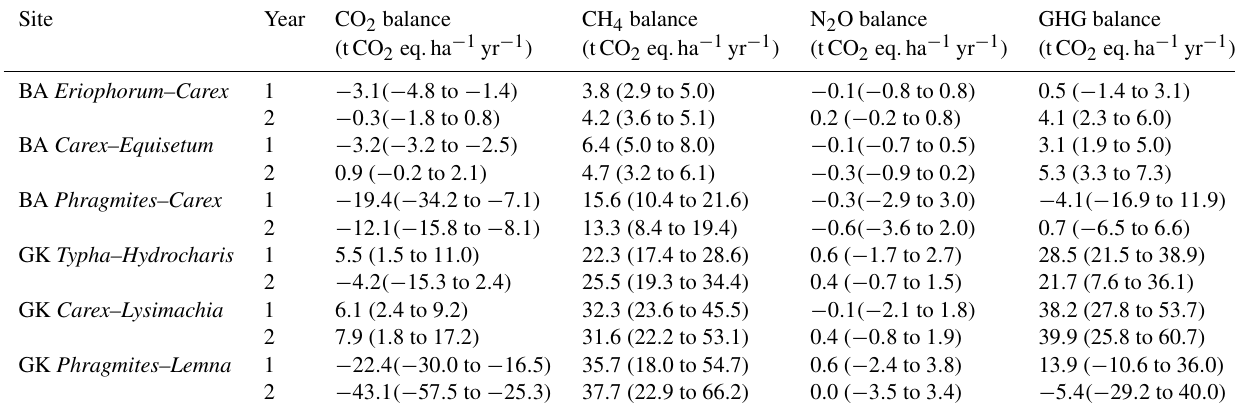
Table 4. GHG balances based on the global warming potentials of CO 2 , CH 4 and N 2 O for a time horizon of 100yr (GWP 100 of CO 2 = 1, of CH 4 = 28 and of N 2 O = 265 CO 2 –equivalents, Myhre et al., 2013) with 90% confidence